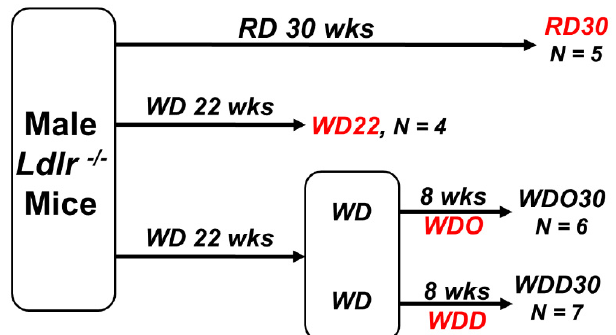
Figure 1. Study design for docosahexaenoic acid (DHA)-mediated nonalcoholic steatohepatitis (NASH) remission in male Ldlr -/- mice. Liver samples used in this lipidomic analysis were obtained from our previously published study assessing the capacity of DHA to promote NASH remission